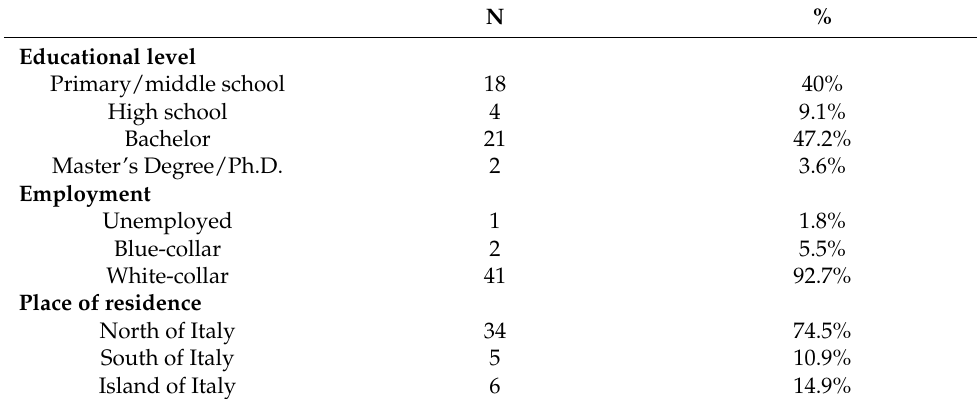
Table 1. Sociodemographic characteristics of participants.